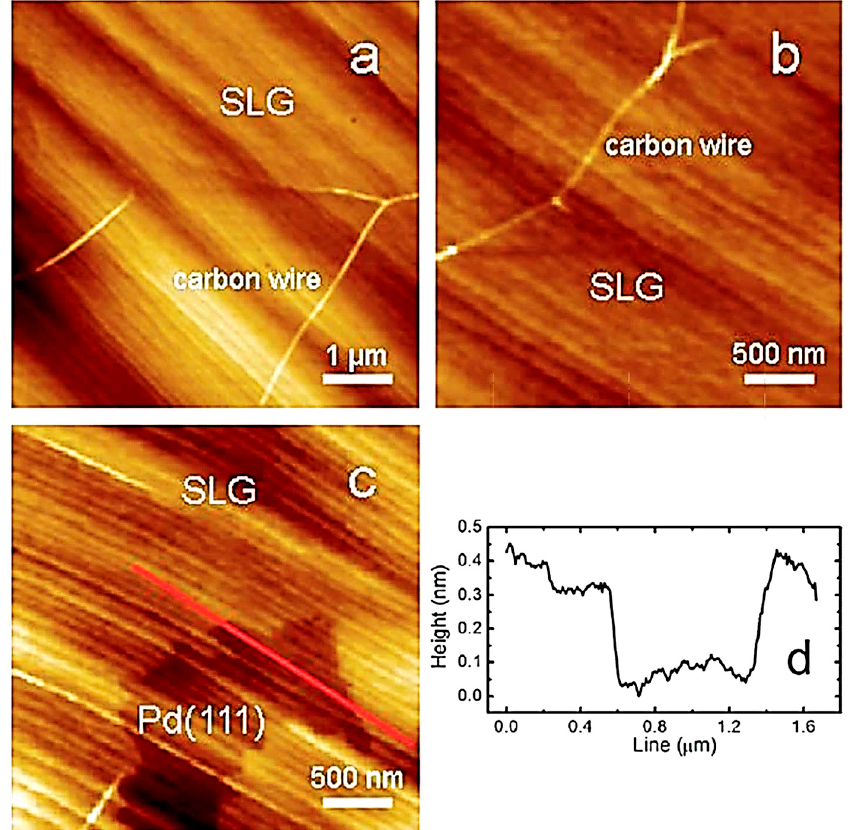
Figure 10. AFM micrographs of Gp produced on Pd (111) substrate. Micrographs ( a , b ) were obtained from the center of the Gp sample, micrograph ( c ) was obtained from the edge of the Gp sample, where ( d ) micrograph illustrates the Gp layer height corresponding to monolayer Gp. Reprinted with permission from [60]. Copyright RSC Publishers, 2017.